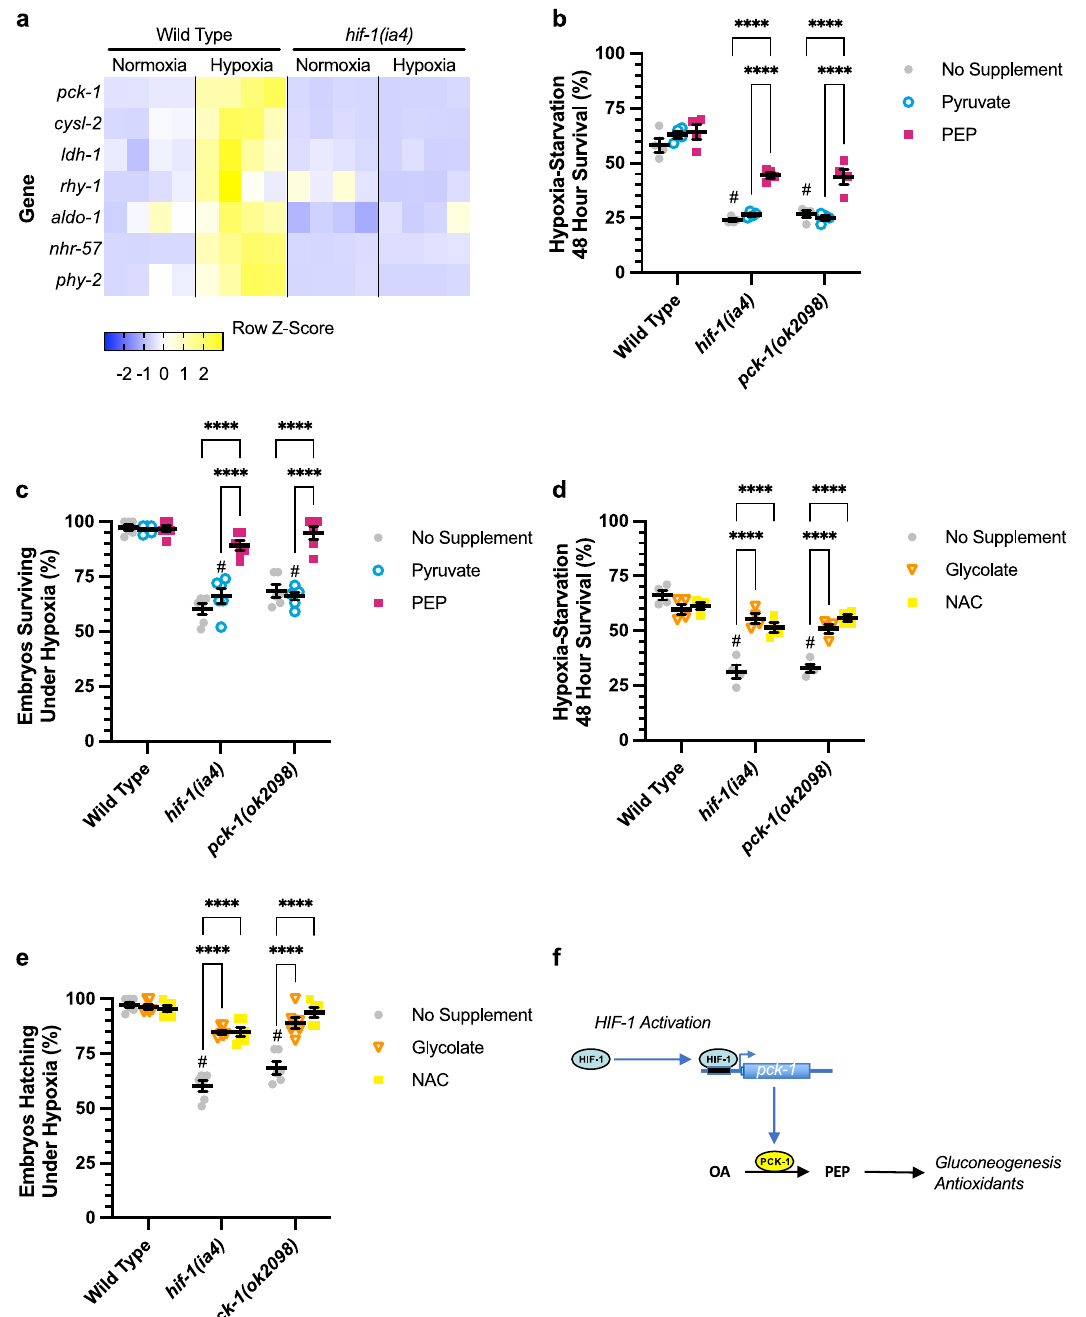
Fig. 4 | HIF-1 targets required for adaptive survival. a Heatmap of row Z-scores for qRT-PCR measurements from L4-stage animals of transcript levels for the indicated genes (rows) as normalized to actin. Columns indicate the genotypes (either wild type or hif-1(ia4) mutants) and experimental conditions (4h under either normoxia or hypoxia (0.5% O 2 ), with four replicates from each genotype/ conditionshown. b , d PercentofL4-stageanimals,grownon fi xed E.coli ,tosurvive liquid culture without food and under hypoxia (0.5% O 2, 48h at 25°C, with 24h recovery at 20°C). Error bars indicate mean±SEM. c , e Percent of embryos, obtained from animals grown on fi xed E. coli , to survive 24h of hypoxia at 25°C, with 24h recovery at 20°C. Animals are indicated by colored symbols, and